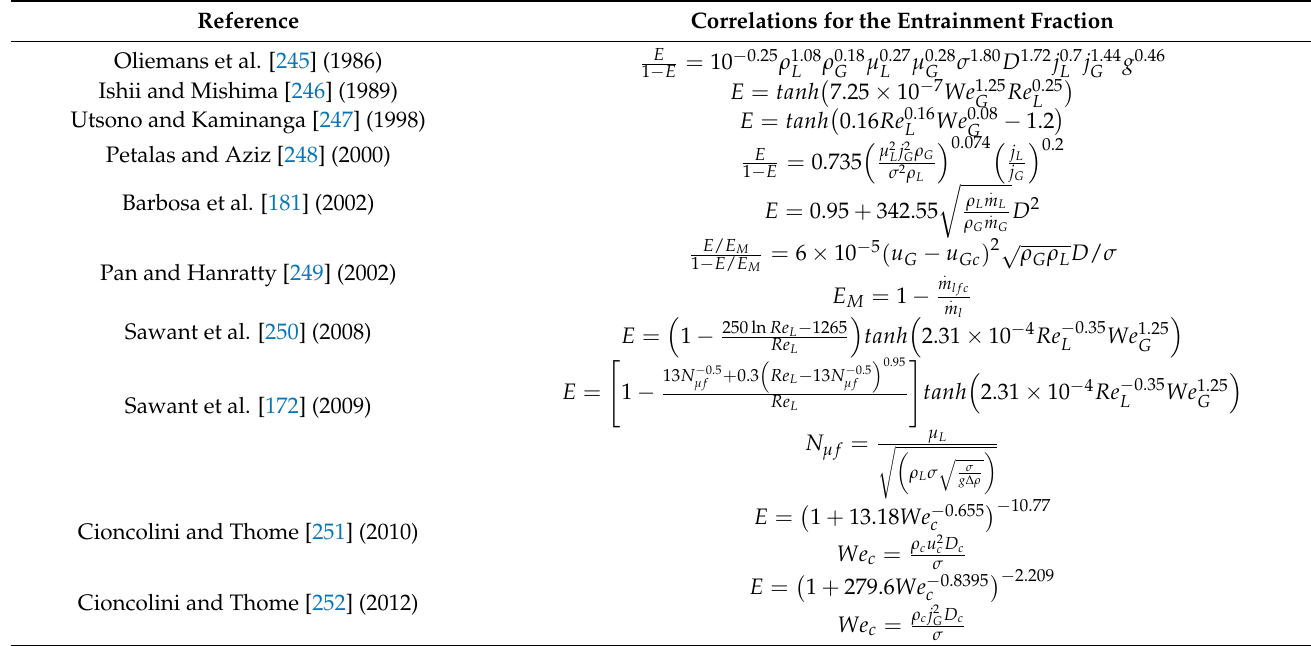
Table 5. Correlations for entrainment fraction in annular two-phase